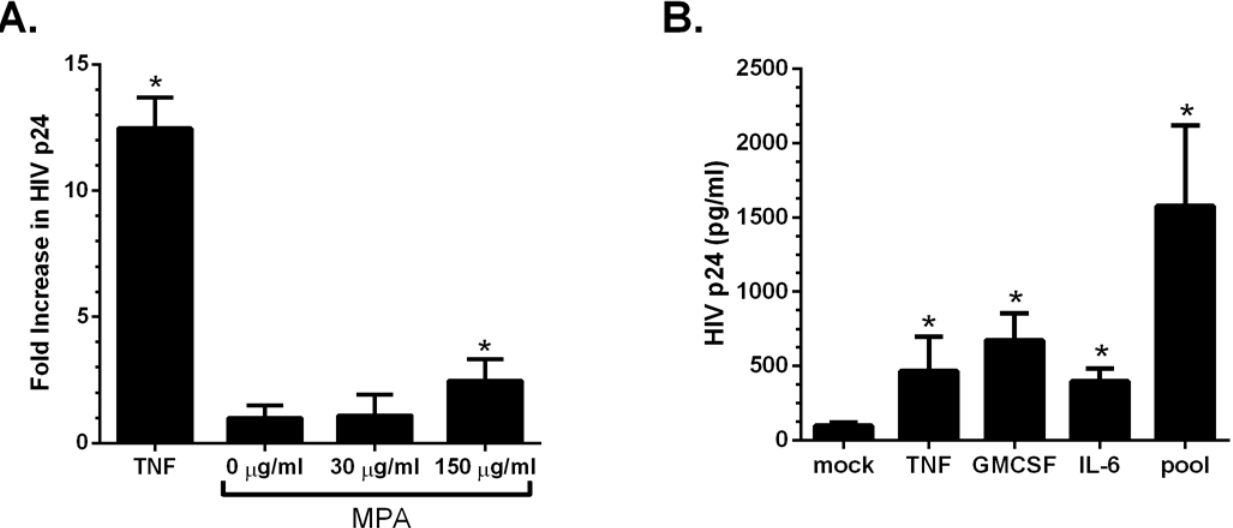
Fig 2. Supernatants from MPA-treated vaginal epithelial cells increase HIV replication in chronically infected U1 cells. VK2/E6E7 cells were plated in the presence or absence of the indicated dose of MPA. At 5 days post-plating, VK2/E6E7 cell supernatants were added to U1 cells and HIV replication was monitored by HIV p24 ELISA on day 4 post-treatment. Controls included supernatants from mock-treated VK2/E6E7 cells (mean HIV p24 1.47 ng/ml) and as a positive control, cells treated with 100 units of recombinant TNF (mean HIV p24 19.365 ng/ml) (A). U1 cells were also treated with recombinant TNF, GMCSF, IL-6, or a pool of these cytokines at concentrations corresponding to levels detected in culture supernatants and HIV replication monitored by measuring p24 levels in supernatants on day 4 (B). Results are mean + SEM of two independent experiments. Asterisks indicate statistically significantly different from mock-treated cells, p < 0.05, Student ’ s t-test.